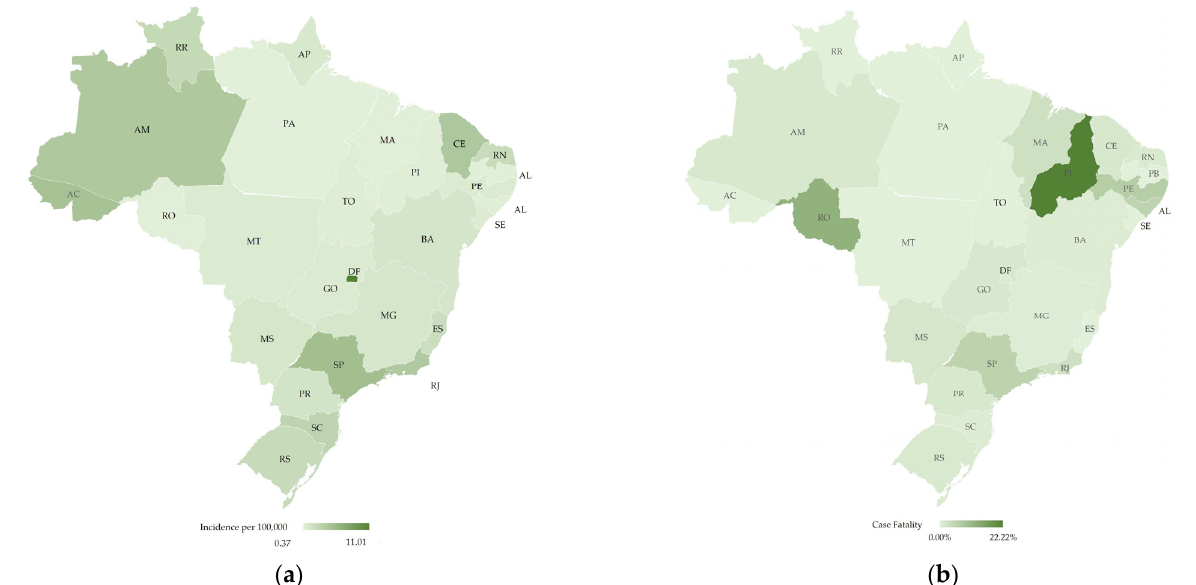
Figure 2. Map of Brazil with the distribution of COVID-19 cases and fatalities by state, elaborated by the authors: ( a ) Incidence of COVID-19 cases per 100,000 people ranging from 0.37 (light green) to 11.01 (dark green); ( b ) Case fatality (%) ranging from 0% (light green) to 22% (dark green). Brazilian states acronym are: Acre (AC), Alagoas (AL), Amapá (AM), Amazonas (AP), Bahia (BA), Ceará (CE), DistritoFederal (DF), EspíritoSanto (ES), Goiás (GO), Maranhão (MA), MatoGrosso (MT), MatoGrossodoSul (MS), MinasGerais (MG), Pará (PA), Paraíba (PB), Paraná (PR), Pernambuco (PE), Piauí (PI), RiodeJaneiro (RJ), RioGrandedoNorte (RN), RioGrandedoSul (RS), Rondônia (RO), Roraima (RR), SantaCatarina (SC), SãoPaulo (SP), Sergipe (SE) and Tocantins (TO).